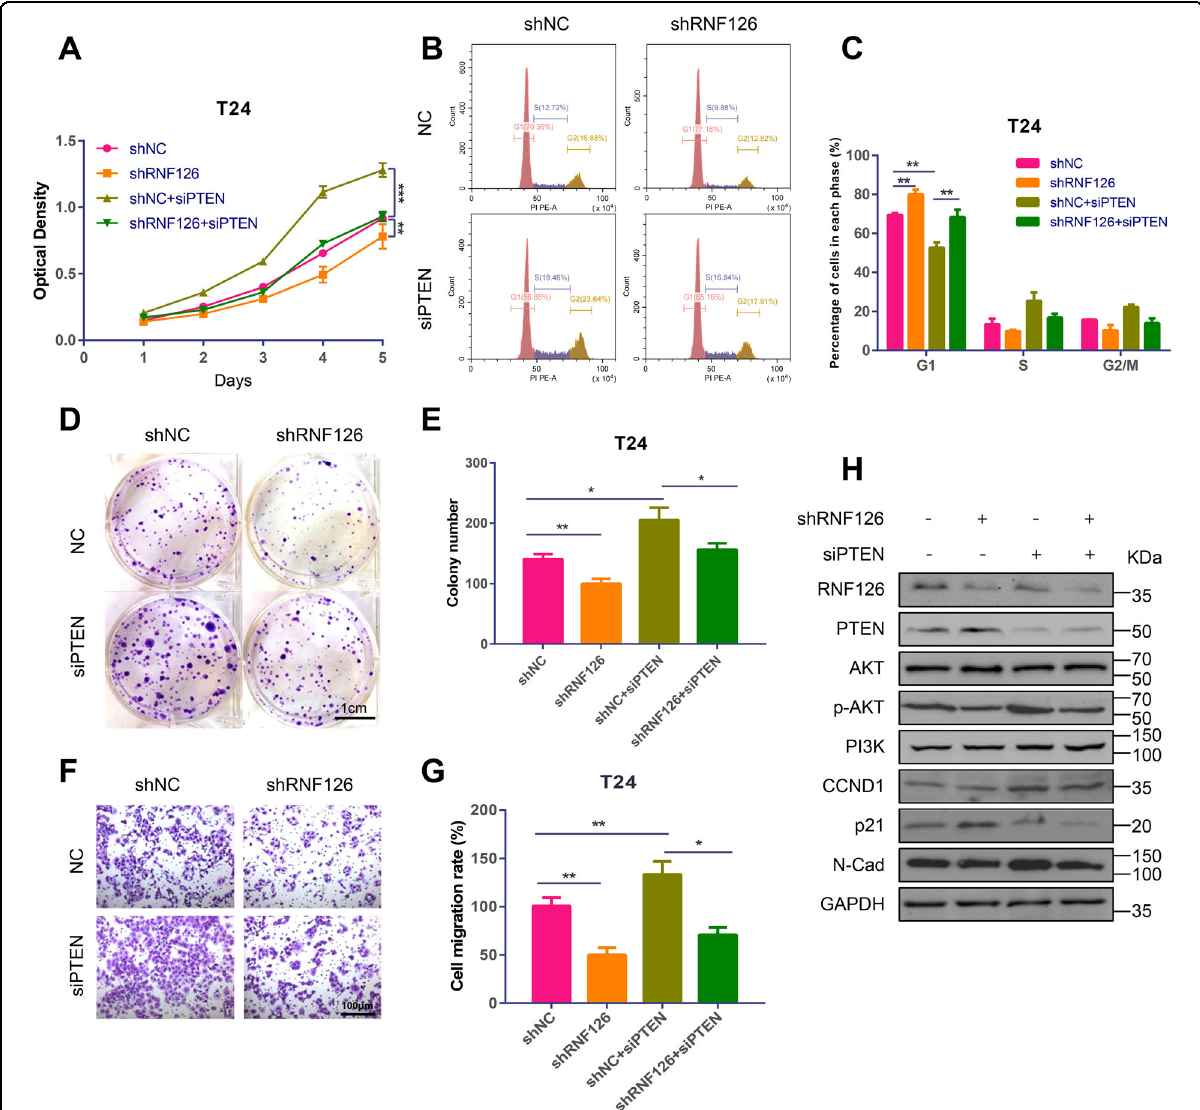
Fig. 6 Depletion of RNF126 suppressed BCa cell proliferation and metastasis through upregulating PTEN. A The MTT assay evaluated the growth and viability of the T24 cell from day 1 until day 5. A lentiviral shRNF126 and a lentiviral control group shNC stably transfected T24 cell were established. The cells were transfected with siNC (red line: shNC and orange line: shRNF126 ) or siPTEN (olive line: shNC + siPTEN and green line: shRNF126 + siPTEN ). B , C The fl ow cytometry analysis demonstrated the distribution of cells in different phases of cell cycle. The four groups were the same as above. D The colony formation assay showed the effect of RNF126 knockdown on the cell survival of UMUC3 and T24 cells after the indicated transfection. Scale bar = 1 cm. E Colony numbers were counted and plotted as indicated. F The transwell assay evaluated cell migration of the RNF126 or PTEN knockdown treated T24 cells. Scale bar = 100 µm. G The relative number of cell migration was statistically analyzed. H The western blotting indicated the protein level of RNF126, PTEN, PI3K, p-AKT, AKT, CCND1, p21, and N-Cad. Loading control was GAPDH. *** p < 0.001, ** p < 0.01, * p <